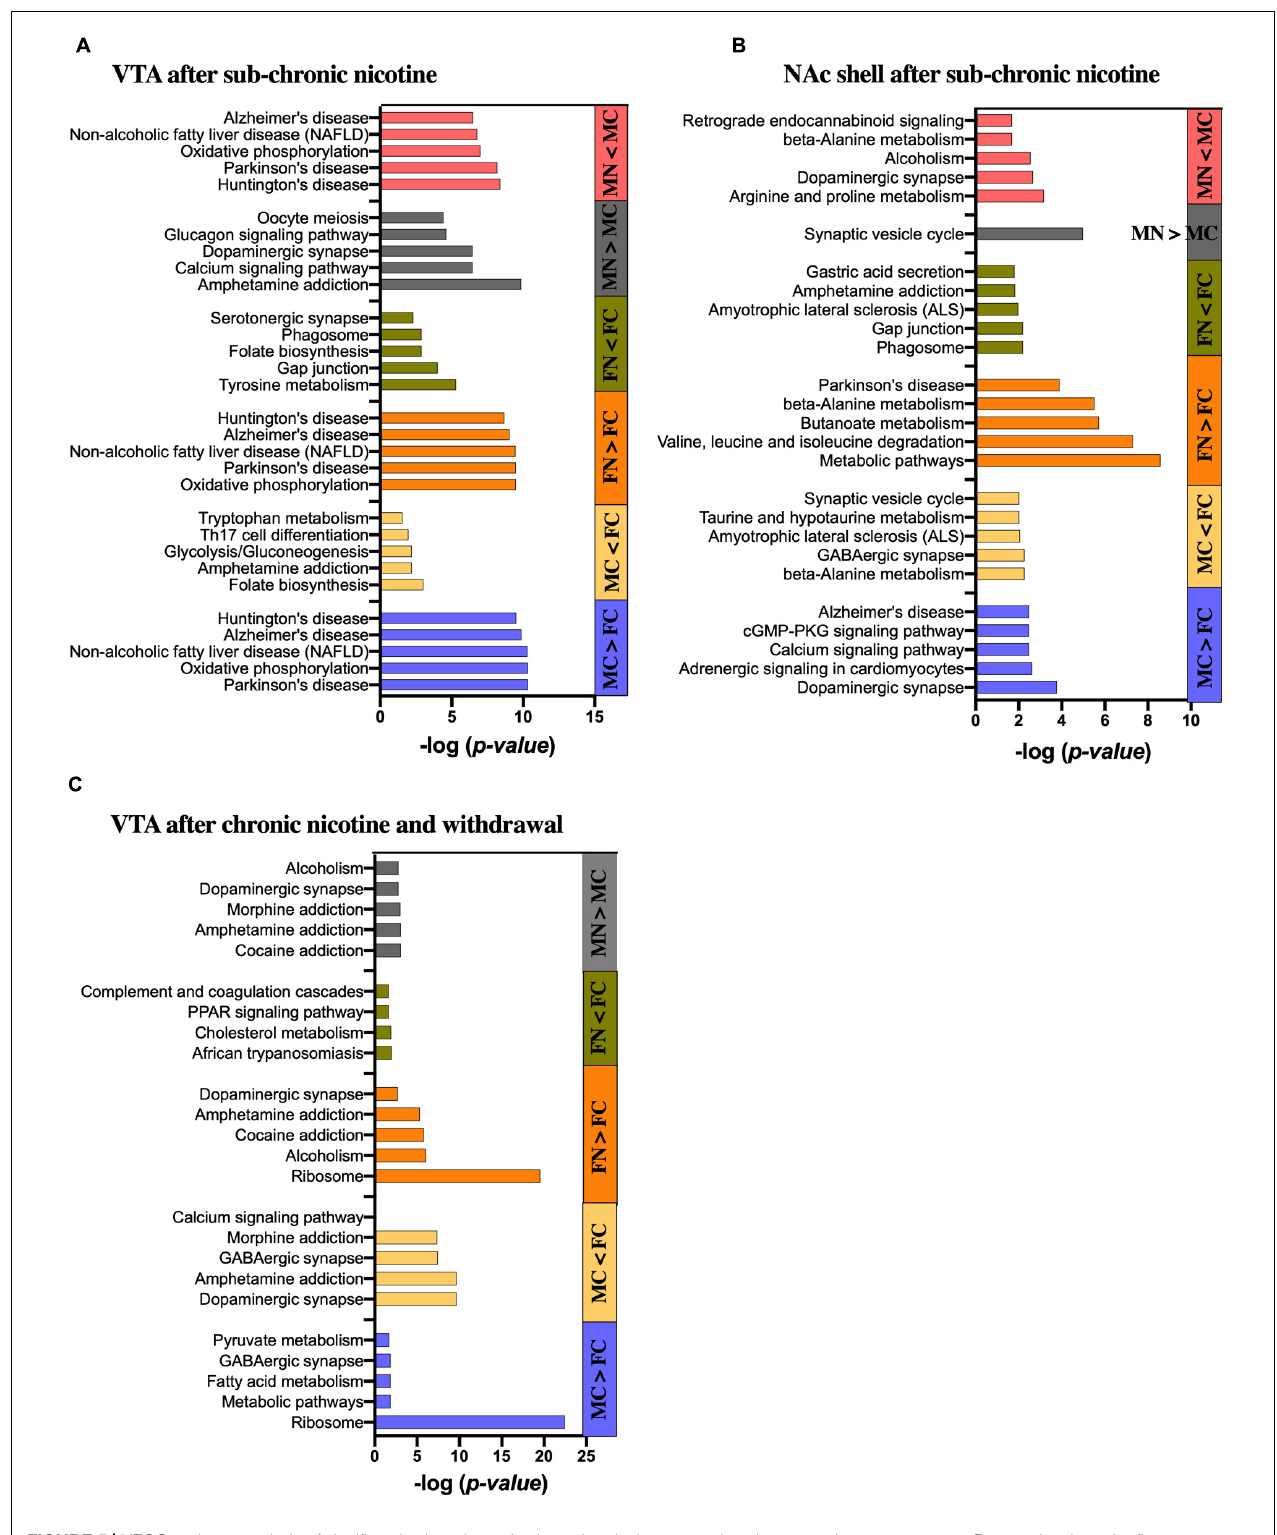
FIGURE 5 | KEGG pathway analysis of significantly altered proteins in each pairwise comparison by sex and treatment group. Bar graphs show the five most significantly enriched KEGG pathways in the significantly up- and down-regulated proteins of each pairwise comparison as indicated in the (A) VTA after sub-chronic nicotine administration, (B) NAc shell after sub-chronic nicotine administration, and (C) VTA after chronic nicotine administration and withdrawal. Where less than five KEGG pathways are shown, only that number of pathways was identified as significantly enriched.